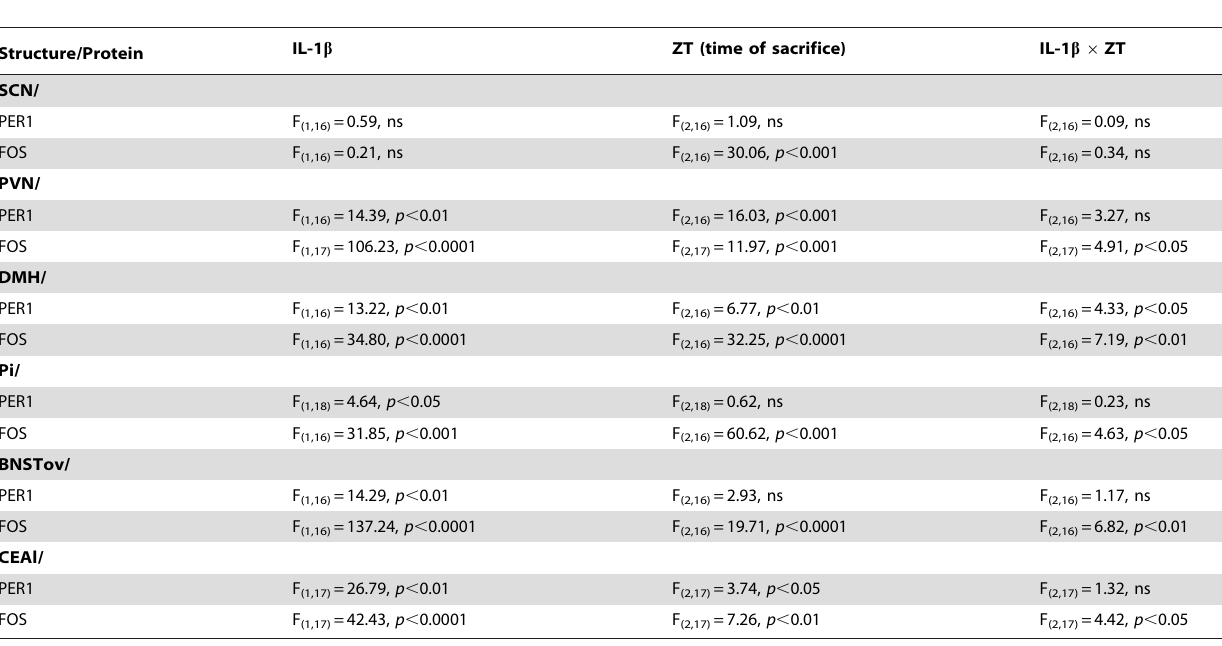
Table 3. Statistical analysis (ANOVA) of the effect of acute IL-1 b challenge on PER1 and FOS expression in hypothalamic and limbic brain regions.